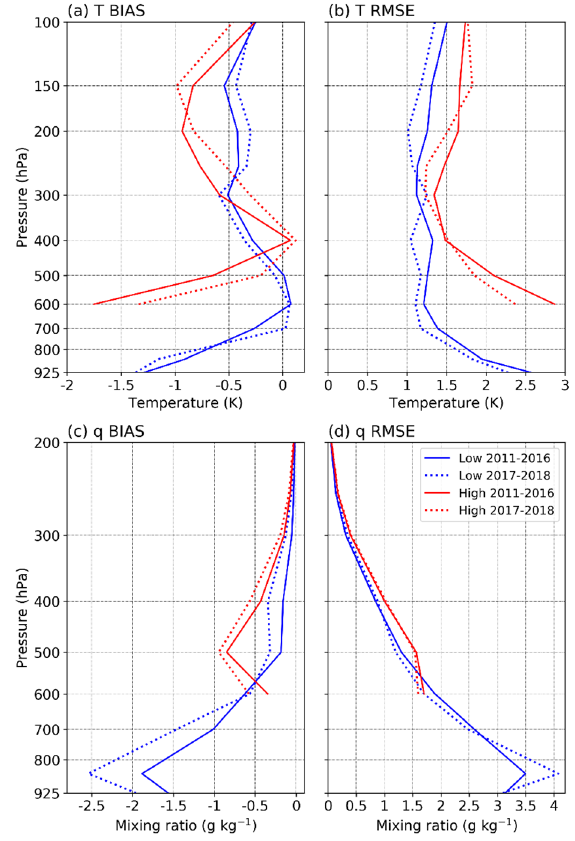
Figure 8. Bias (left column) and RMSE (right column) for the AIRS-only (AO) data from 2011 to 2016 (solid lines) and from 2017–2018 (dashed lines) for low-altitude and high-altitude sites. ( a ) shows bias of T, ( b ) RMSE of T, ( c ) bias of q, and ( d ) RMSE of q.